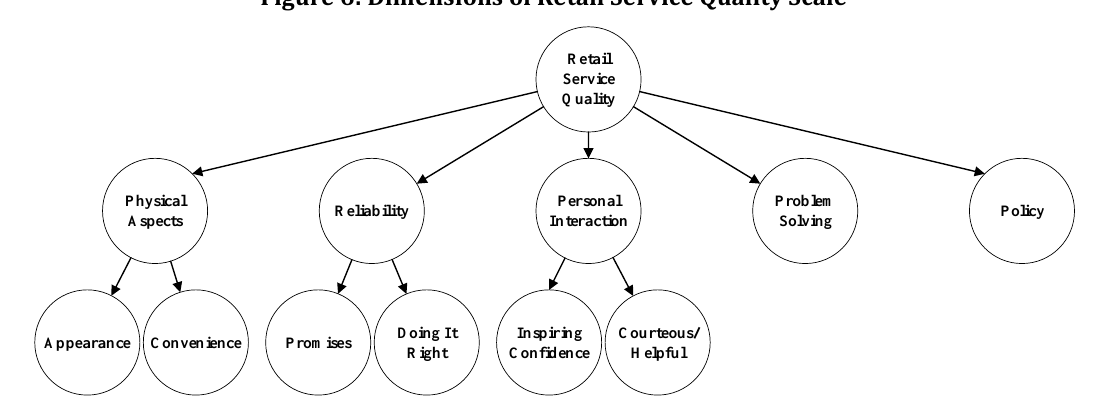
Figure 6: Dimensions of Retail Service Quality